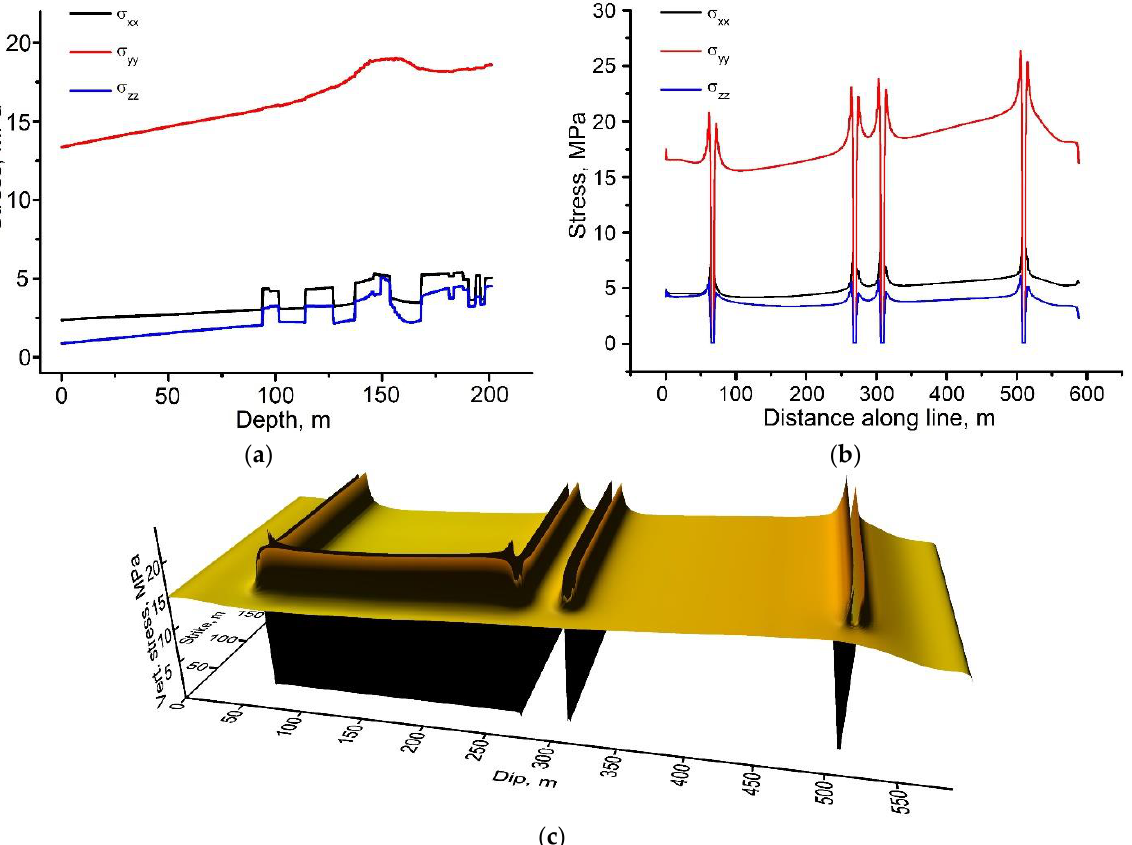
Figure 4. Distribution of normal stresses along: the vertical line drawn through the center of the model ( a ), the line drawn through the center along the dip direction of seam 3 ( b ), and the initial vertical stress distribution in seam plane ( c ).